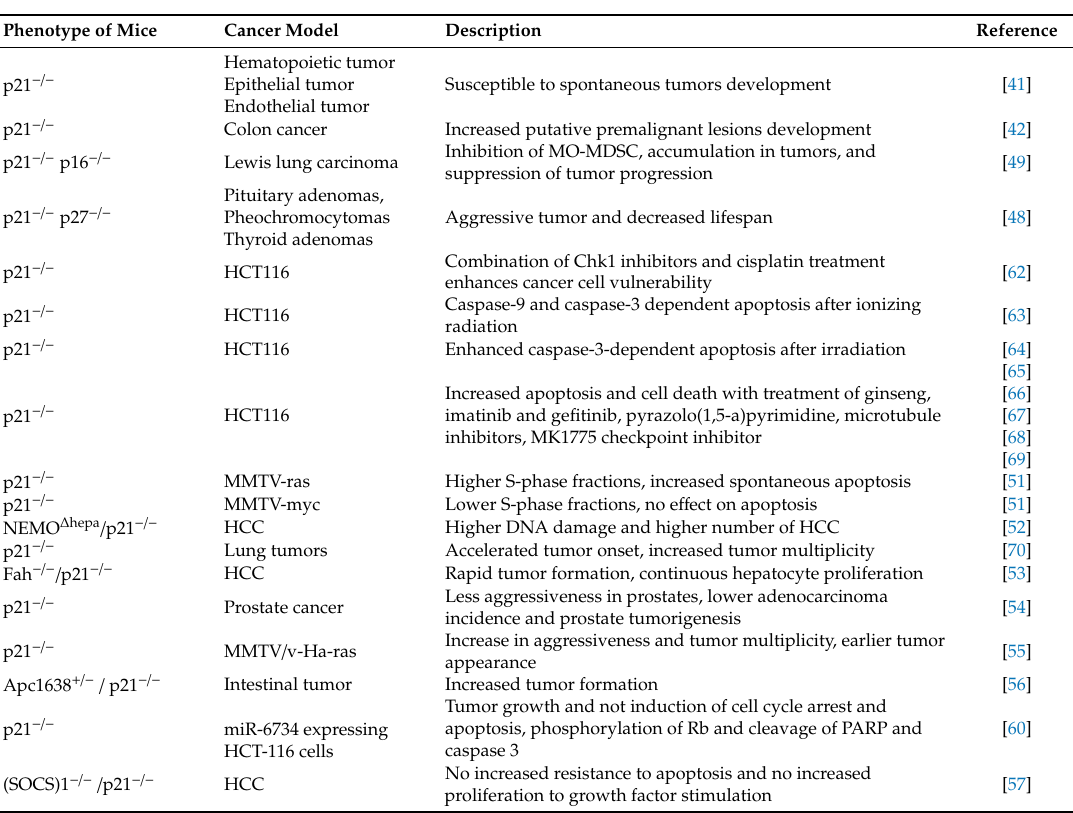
Table 1. p21 deficient in vivo and in vitro models used in p21-cancer